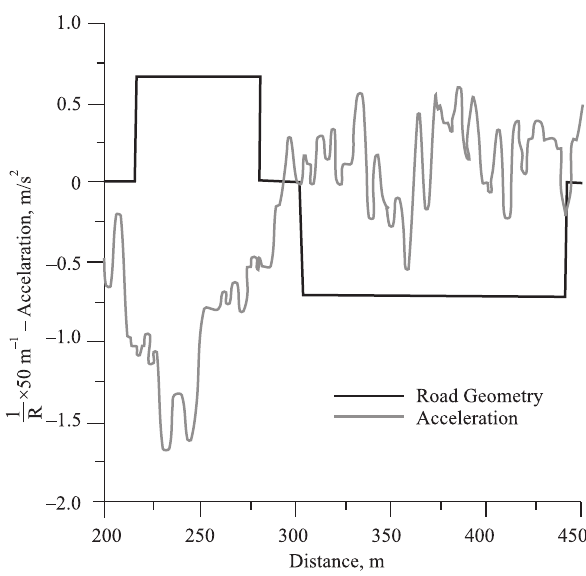
Fig. 4. Position of the vehicle in respect to the centre line of the lane to verify the presence of overload